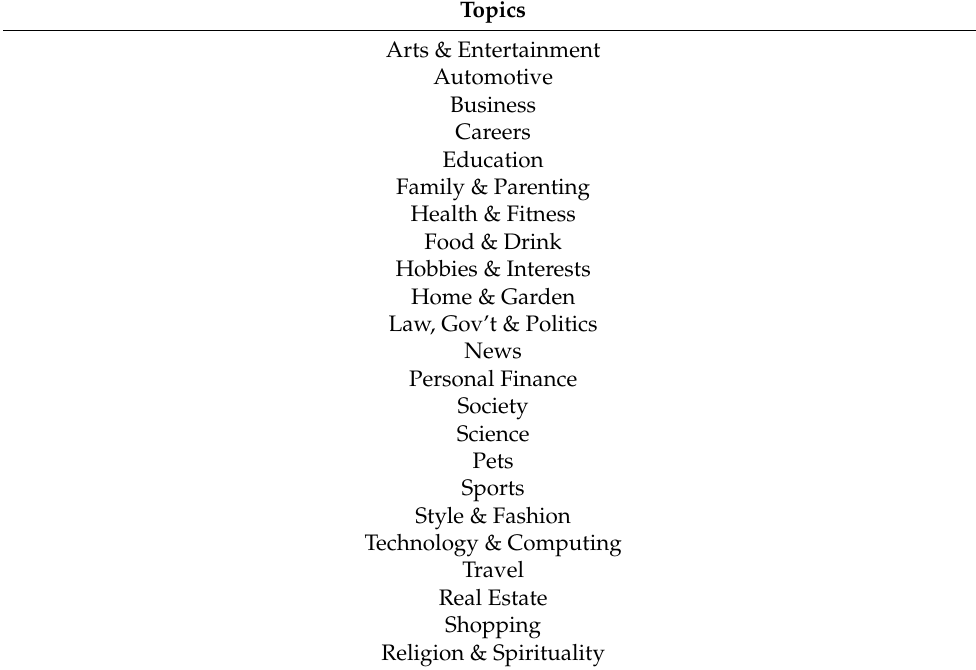
Table 3. Categories